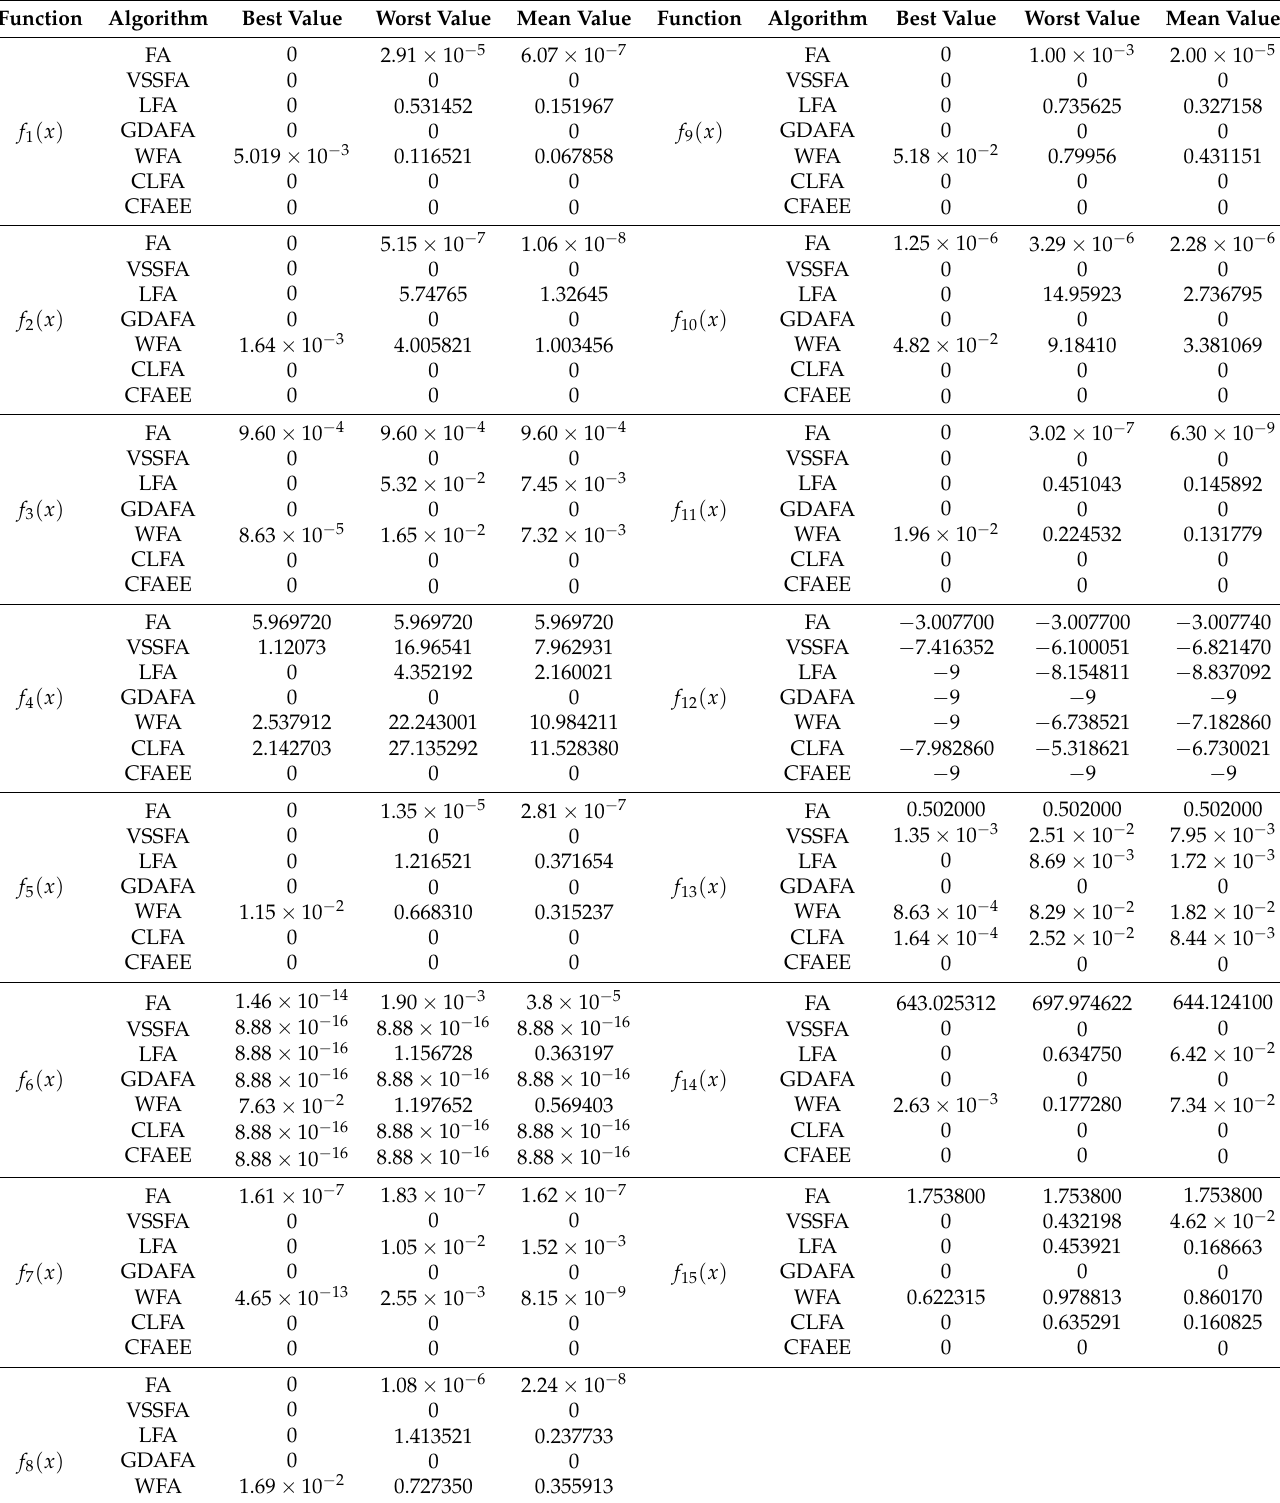
Table 3. Comparative analysis among CFAEE, original FA, and five other FA implementations for benchmarks with 10